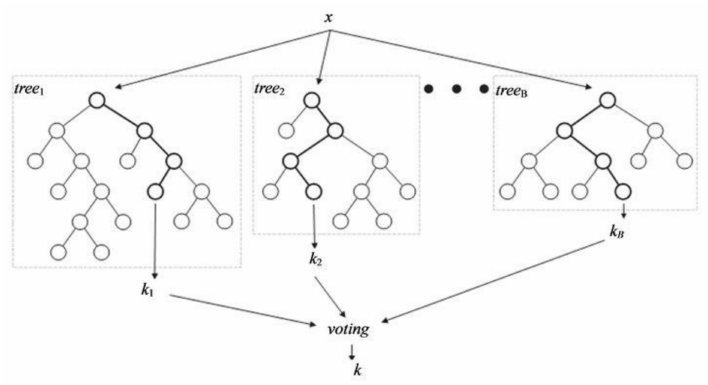
Figure 9. Random forest method.